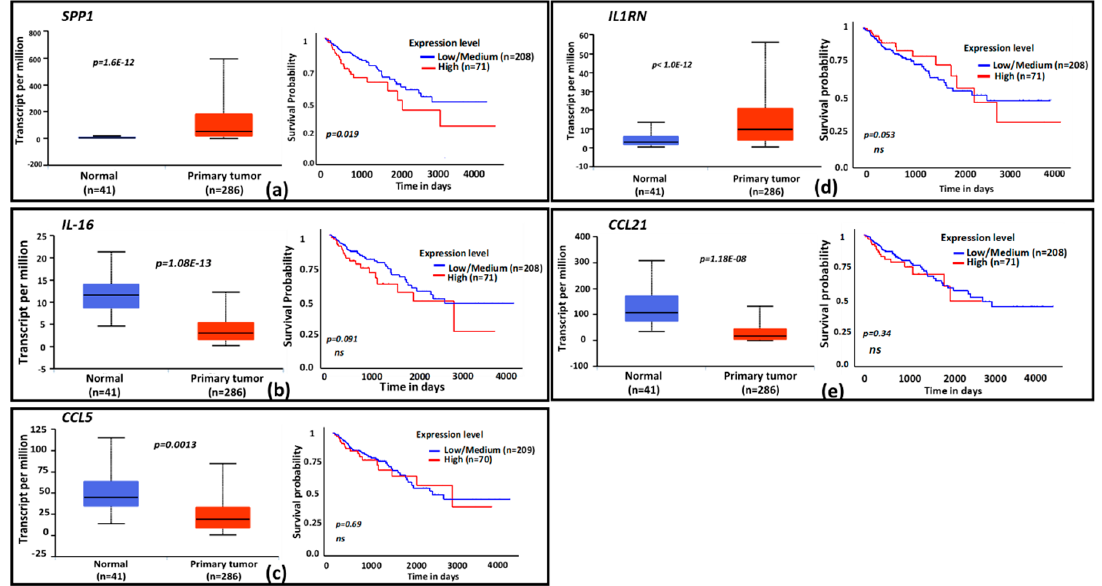
Figure 3. Expression profiles and functional categories of CPT-responsive genes and survival prognosis based on gene expression. Cytokine genes identified as CPT-responsive were probed for clinical significance in The Cancer Genome Atlas (TCGA) database. Graphs for the 5 genes with significant expression and / or survival probability in the database are shown. ( a–e ), The TCGA colon adenocarcinoma (COAD) database was probed for gene expression and patient survival profiles by using the UALCAN portal. Box plots indicate relative gene expressions between normal tissues and primary tumors; line graphs are Kaplan–Meier patient survival curves for relatively low (blue) or high (red) gene expressions. Genes: ( a ) = SPP1 , ( b ) = IL-16 , ( c ) = CCL5 , ( d ) = IL1RN , ( e ) = CCL21 . The x-axis shows survival time in days; the y-axis shows survival probability. ns = nonsignificant. n = number of specimen analyzed for gene expression or number of patients in the survival curve computation.